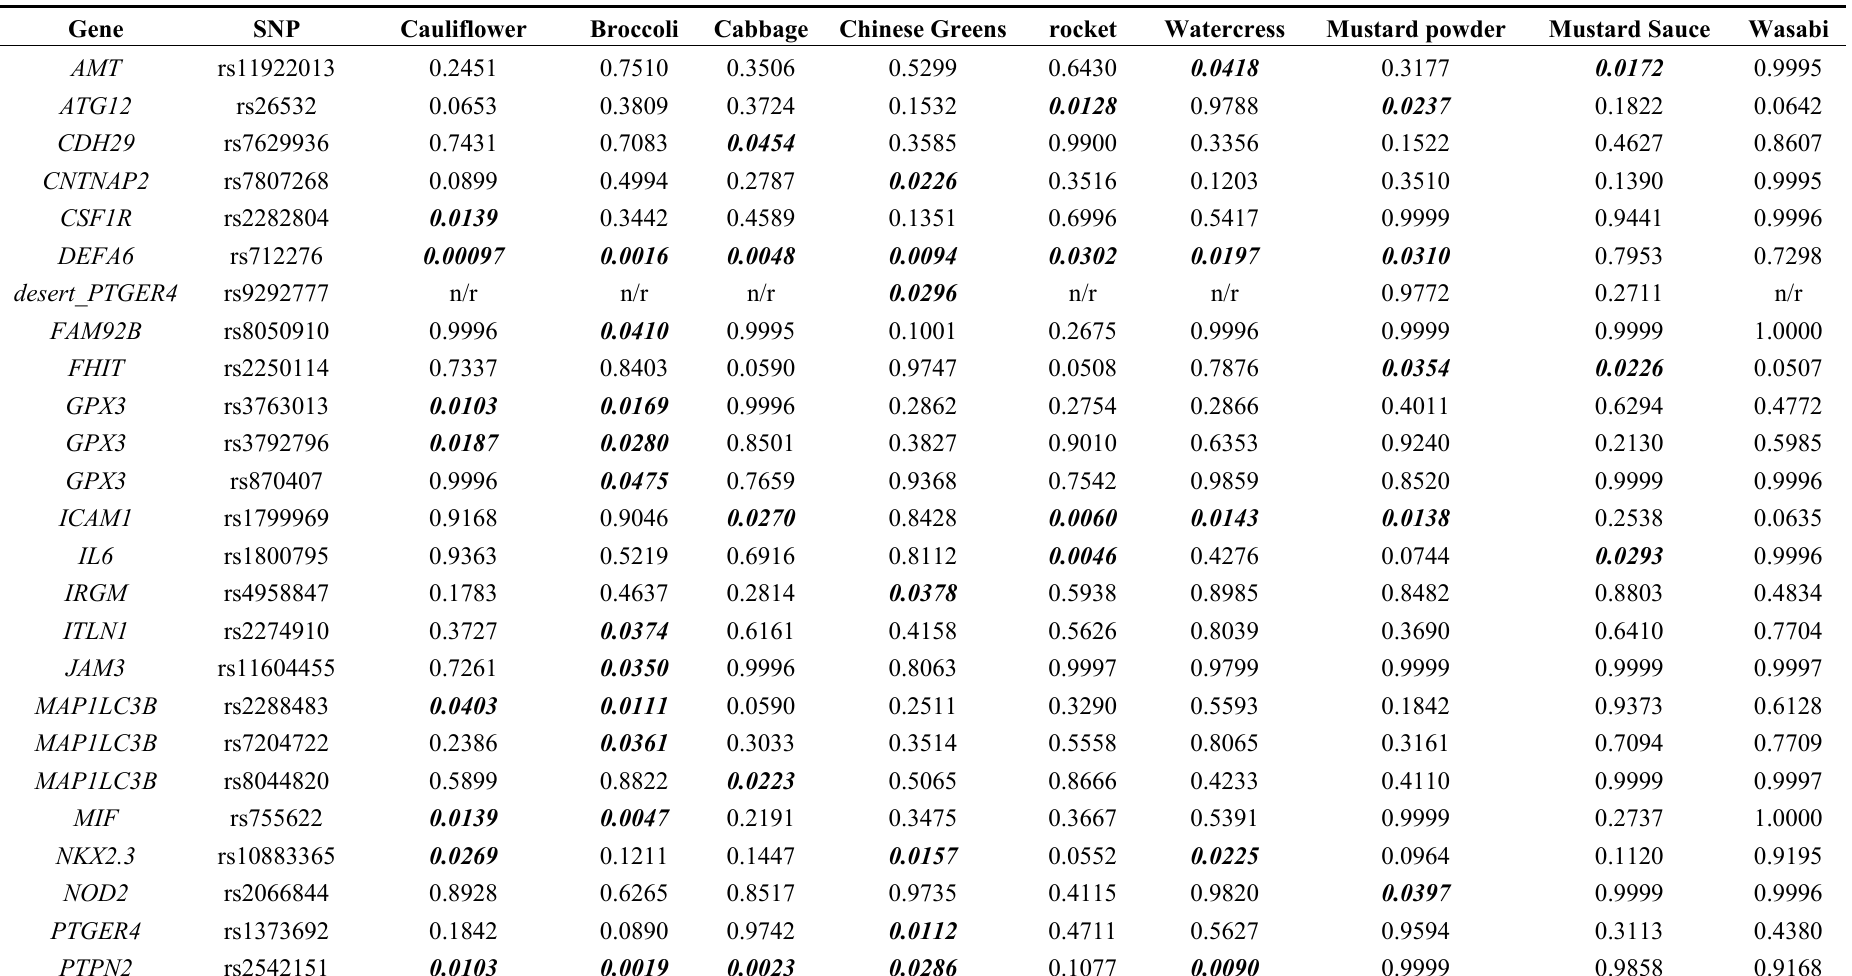
Table 3. Results of SNPs from the candidate genes associated with beneficial effects of Brassicaceae; showing p -values only; significant p values highlighted in italic and bold; n/r: no